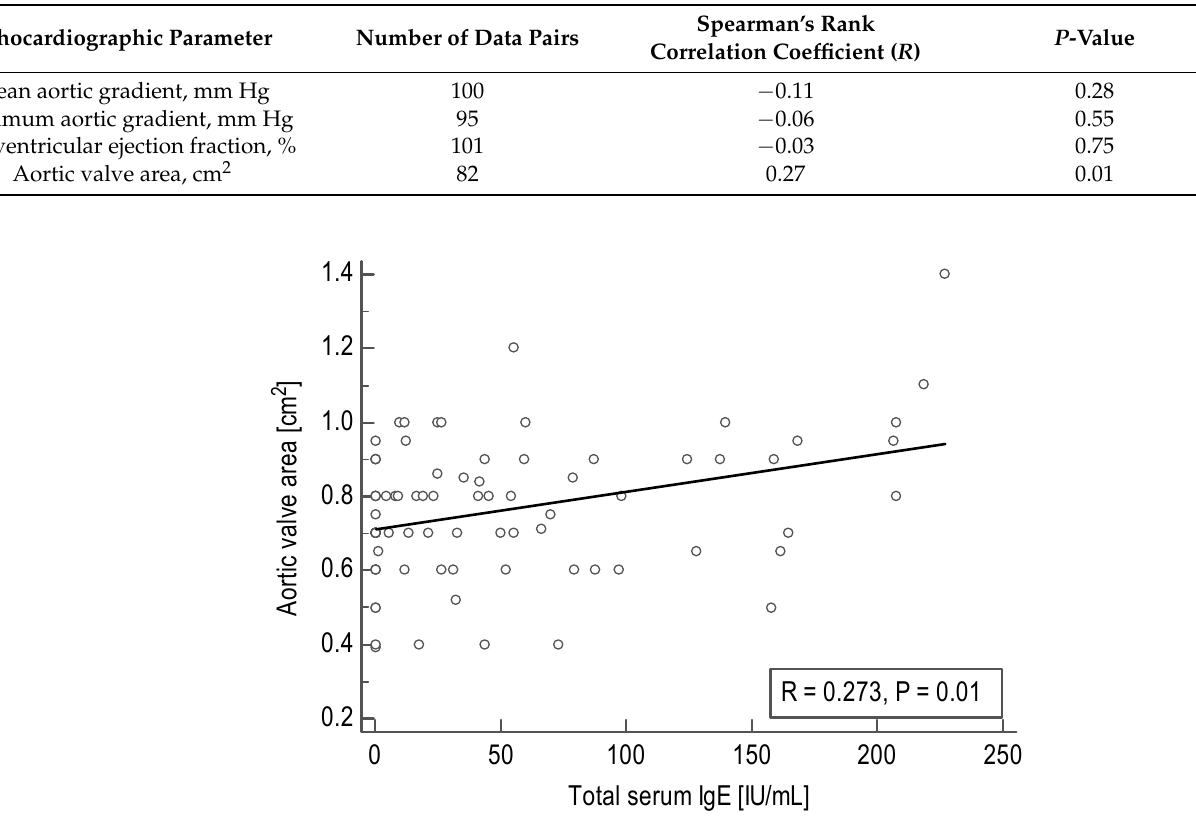
Figure 1. Correlation between aortic valve area and total serum immunoglobulin (IgE) levels in acquired aortic stenosis patients calculated using Spearman’s coefficient of rank correlation ( R ).